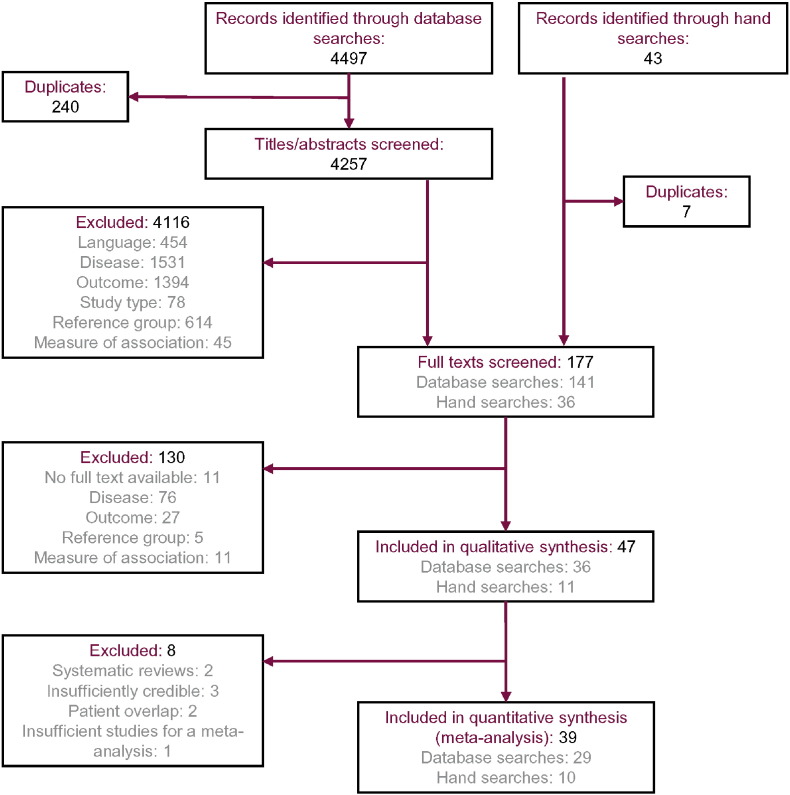
PRISMA flowchart.